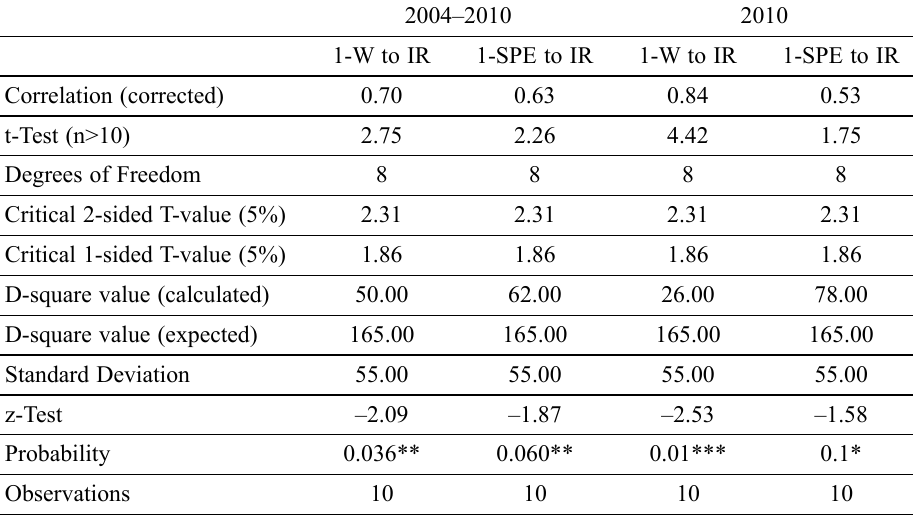
Table 1. Spearman’s rank correlation coefficient of social spending, net earnings and